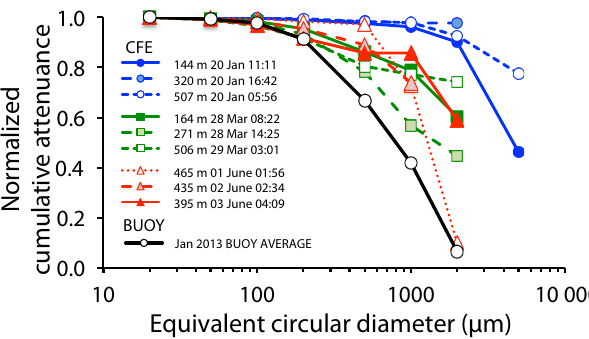
Figure 10. Comparison of normalized cumulative volume attenu- ance size particle distribution (NCVA-PSD) for images from CFE and BUOY-OSR systems, January 2013. Over 96% of the cumu- lative volume attenuance loading was in the >1000µm fraction in CFE samples. The BUOY system images at 11:26 and 18:08 cor- responded to times when current velocity above the mouth of the trap was 6cms − 1 and less than 2cms − 1 , respectively. The NCVA- PSD for the BUOY-OSR can be matched by eliminating all of the >1500µm sized material from the CFE size distributions.